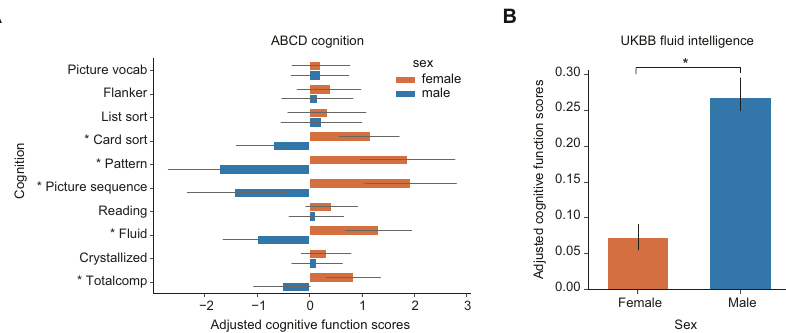
Fig. 1 Sex differences of cognitions in healthy children and adults. The average adjusted cognitive function scores for children and adults. A , B Comparison of cognitive functions for males (blue) and females (red) in ABCD and UKB, respectively. Linear regression models were computed with cognition as the outcome and age as the predictor then the residuals were saved as adjusted cognitive function score. The error bar represents the standard deviation of adjusted scores. *